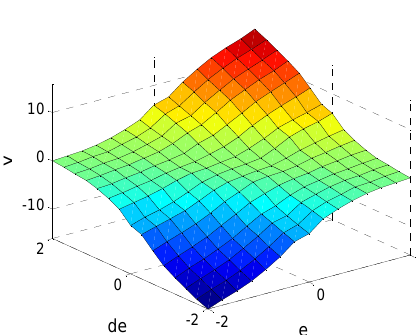
Fig. 12. Control surface of the PDFLC in Example 2.